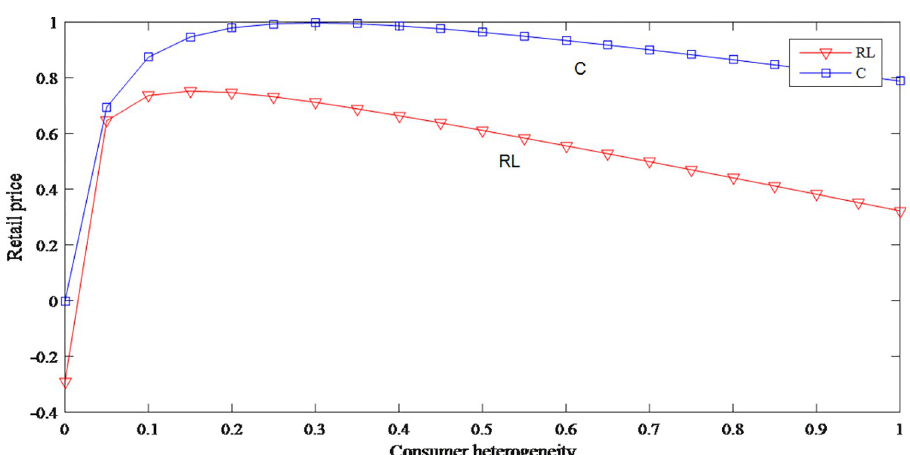
Fig 14. The impact of consumer heterogeneity on retail price.